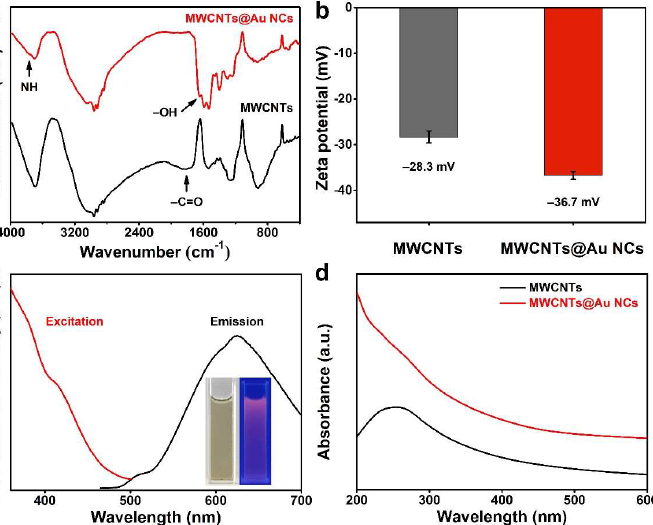
Figure 2. ( a ) FTIR spectra and ( b ) zeta potentials of MWCNTs and MWCNTs@Au NCs. ( c ) Fluores- cence excitation and emission spectra of MWCNTs@Au NCs (the inset shows the optical photo- graphs of MWCNTs@Au NCs under sunlight (left) and 360 nm UV light (right)). ( d ) UV–vis absorp- tion spectra of MWCNTs and MWCNTs@Au NCs.